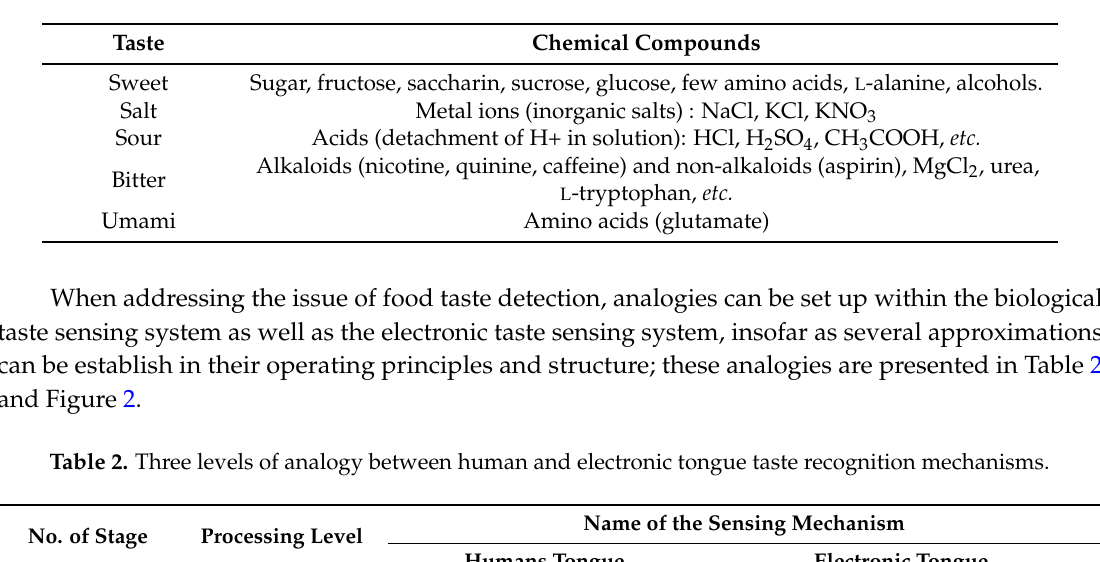
Figure 1. Quantification of food palatability. Table 1. Chemical compounds for taste appreciation categorization.